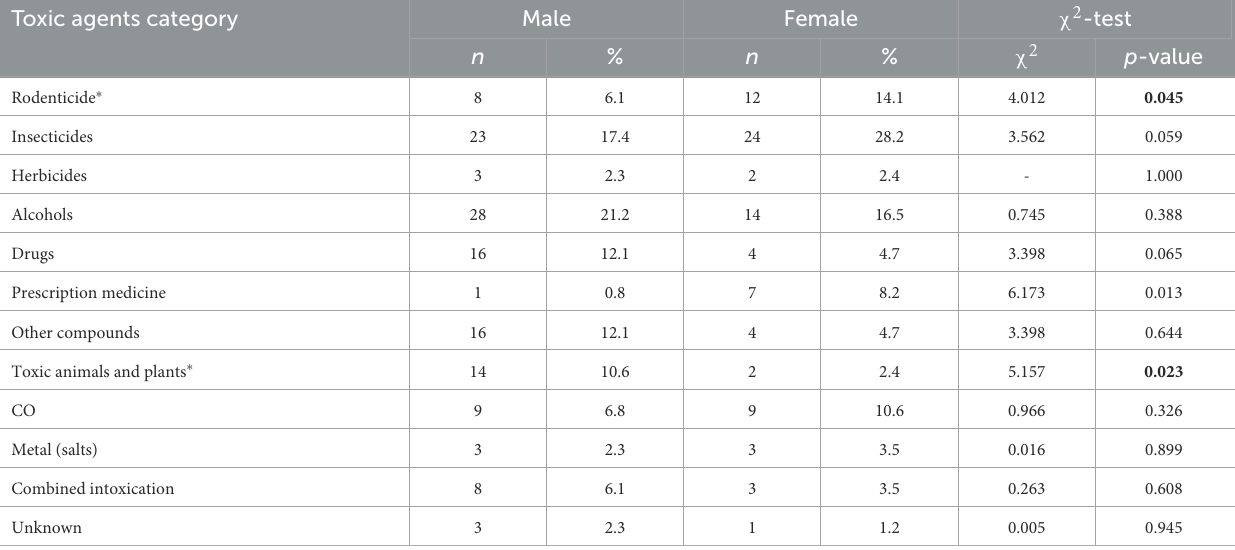
TABLE 4 Sex distribution of intoxication deaths from 2009 to 2021. Toxic agents